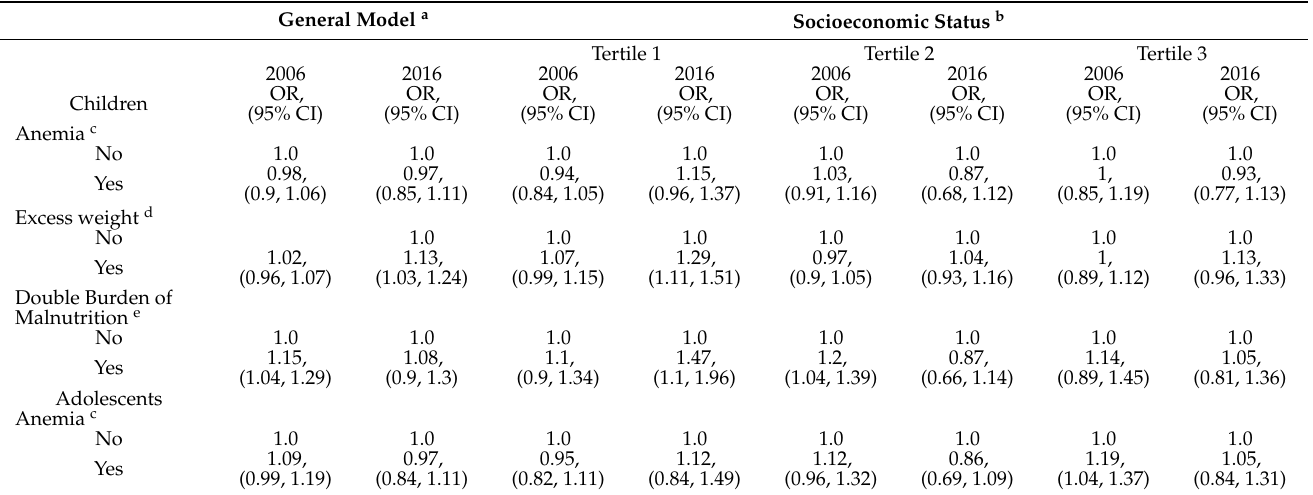
Table 3. Adjusted analyses of the association between the dietary intake of ultraprocessed products and health conditions in Mexican children and adolescents by